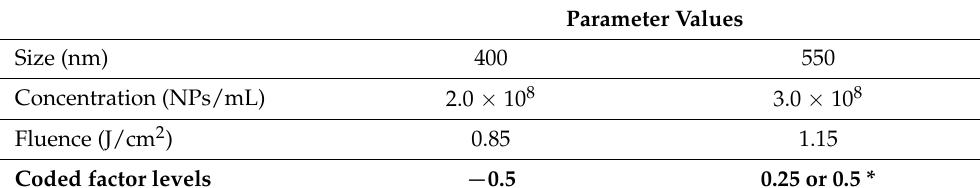
Table 6. Overview of the parameter values included in the confirmatory runs and their conversion to coded values (bold) as they are used in the RSM model. * Coded factor level for a size of 550 nm is 0.25, while the other parameter values in that column correspond to coded factor levels of 0.5.